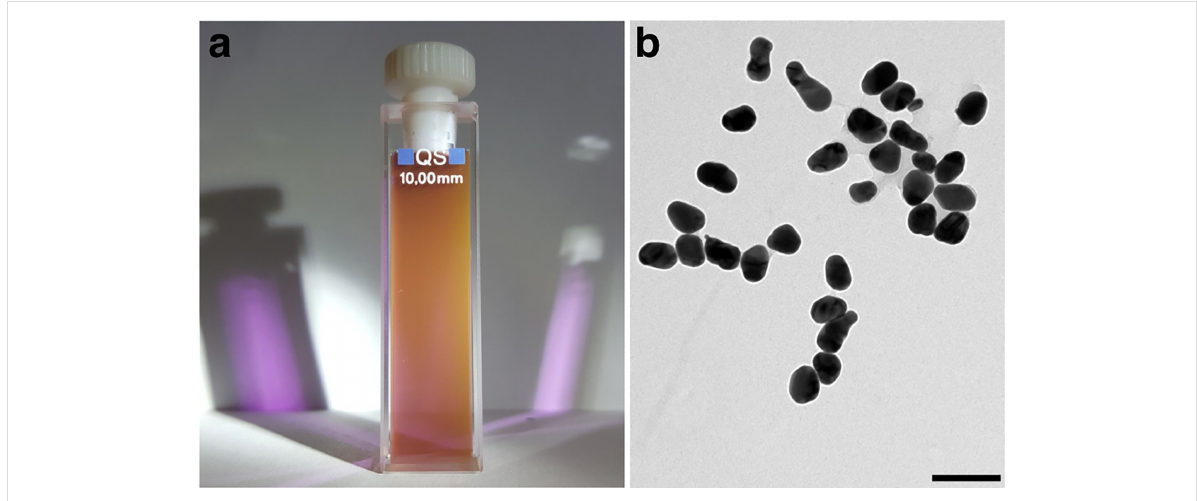
Figure 1: a) A dichroic AuNP solution. Here both the brown reflection and purple transmission can be observed. b) TEM micrograph of the AuNPs, scale bar 100